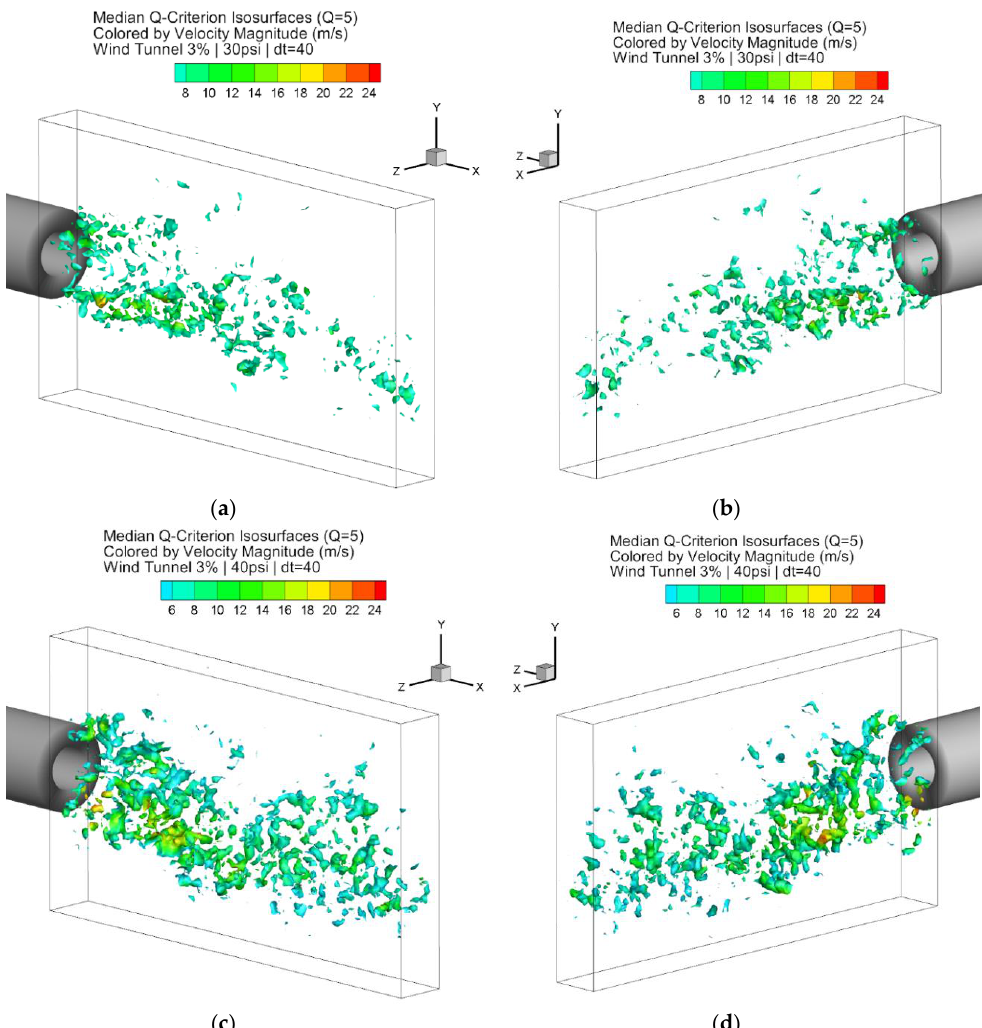
Figure 20. Instantaneous Q-Criterion isosurfaces for the 3% freestream setting and vortex pressure set at 30 psi ( a , b ) and 40 psi ( c , d ), each from two perspective views.